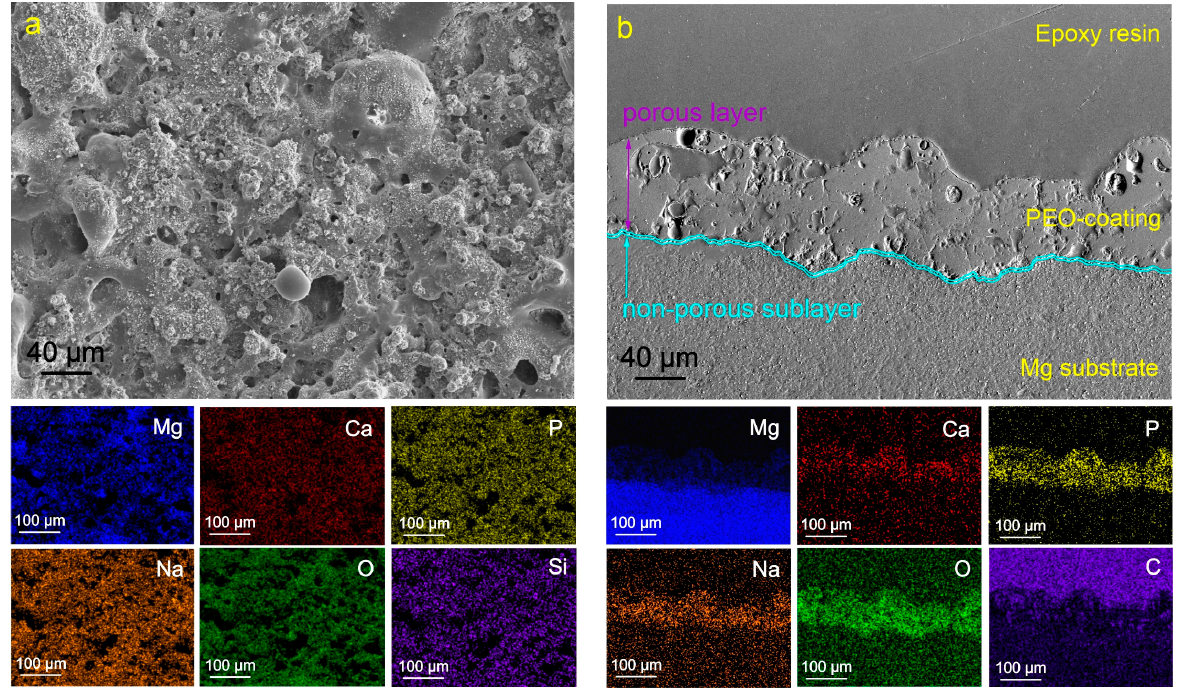
Figure 1. SEM images of the surface ( a ) and cross-section ( b ) of the PEO-coated samples and maps of elements distribution over the sample’s surface ( a ) and thickness ( b ).